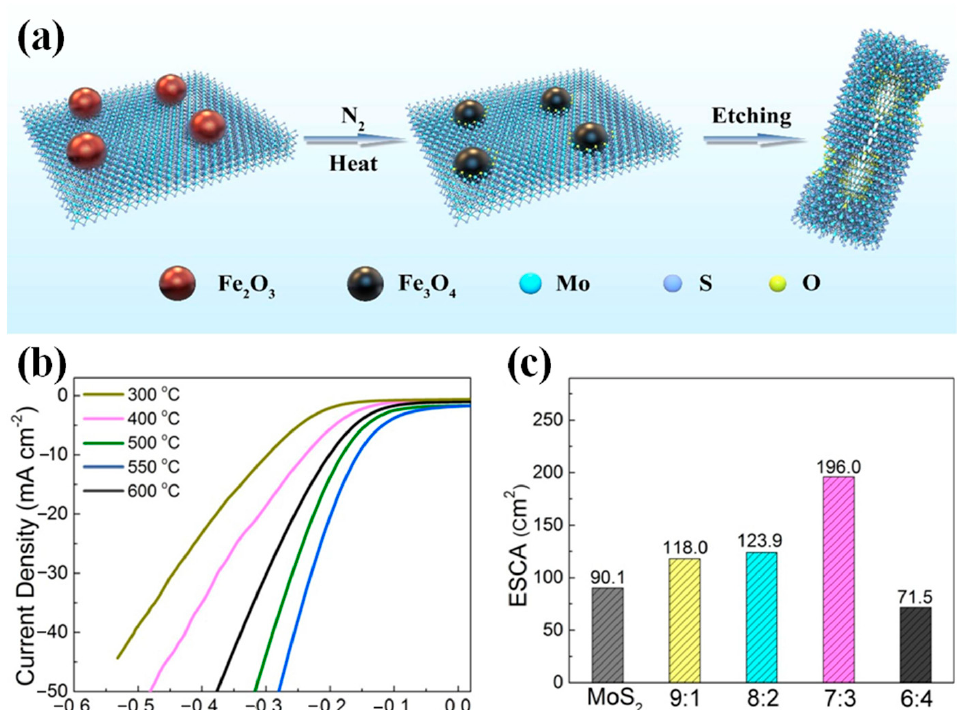
Figure 8. ( a ) Preparation scheme of porous MoS 2 /MoO 2 hybrid. ( b ) HER polarization curves of the MoS 2 /MoO 2 samples annealed at different temperatures. ( c ) Electrochemical surface areas (ECSA) of MoS 2 /MoO 2 with different Mo/Fe molar ratios (9:1, 8:2, 7:3, and 6:4). Reproduced with permission from [70]. Copyright 2020, Elsevier.